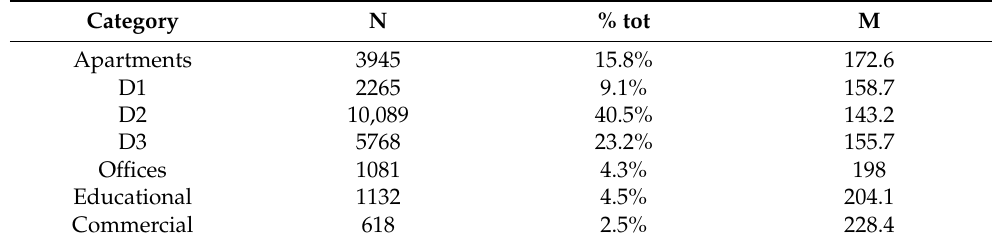
Table 1. EPC summary for all building categories: number N, % over the total, mean M (kWh/(m 2 a)). Category N % tot M Apartments 3945